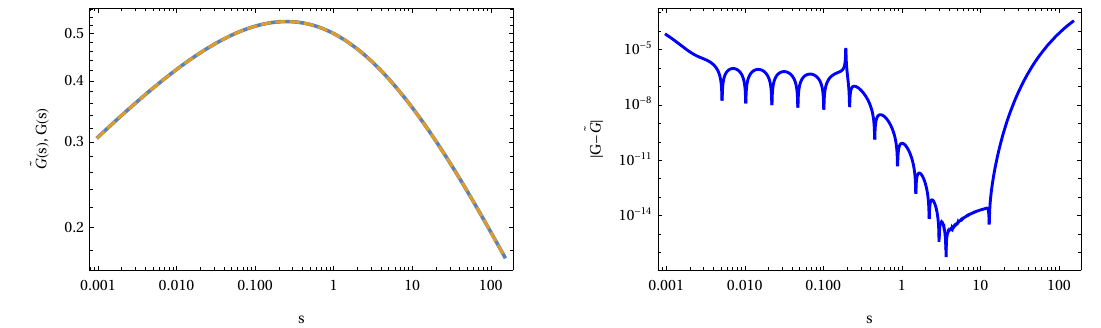
Figure 9. Approximation of the transfer function G ( s ) for a fractional relaxation equation given by (94). The left panel shows the exact transfer function G ( s ) with χ 0 = 1, τ = 1, α = 1/2, and β = 1/3 in connection with the approximation using Thiele’s algorithm. The right panel shows the local error between the exact function and its approximation. The total number of points used in the approximation is m = 2 N + 1 = 35.